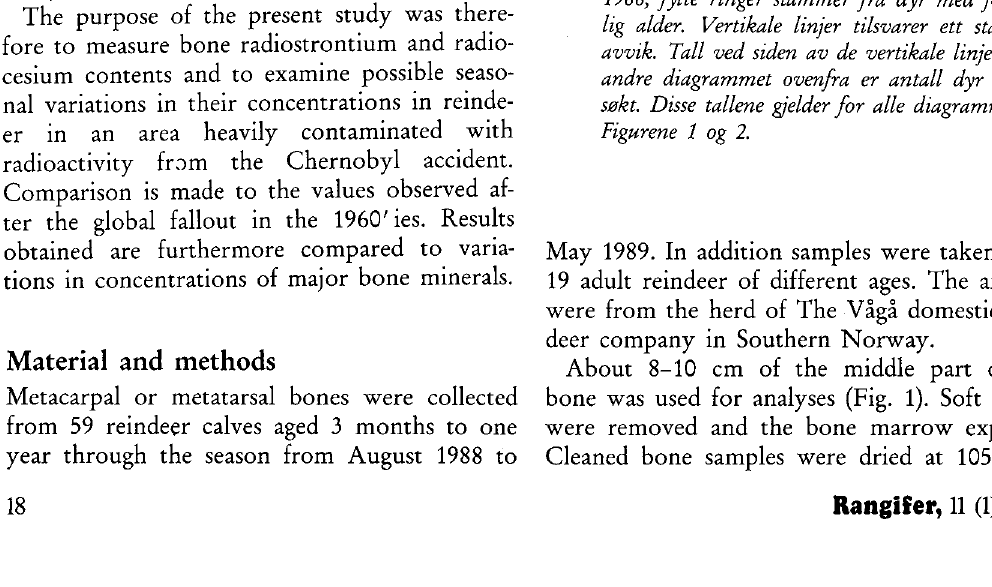
Fig. 1. Radiocesium ( 137 Cs) and radiostrontium ( 90 Sr) in metacarpal or metatarsal bones from reinde er in the Vågå reindeer herding district in so uthern Norway. Fully drawn lines between open rings calves born in May 1988, black dots adult animals of different ages. Vertical li nes one S. D., figures beside S. D. in second diagram from above number of animals. These figures apply to all diagrams in Figs. 1 and 2. Fig. 1. Radiocesium ^ 37 Cs) og radiostrontium ^°Sr) i metacarpus eller metatarsus fra rein tilhørende Vågå tamreinlag i Sør-Norge. mellom åpne ringer er fra kalver født 1988, fylte ringer stammer fra dyr med forskjel lig alder. Vertikale linjer tilsvarer ett standard avvik. Tall ved siden av de vertikale linjer i det andre diagrammet ovenfra er antall dyr under søkt. Disse tallene gjelder for alle diagrammene i Figurene 1 og 2.